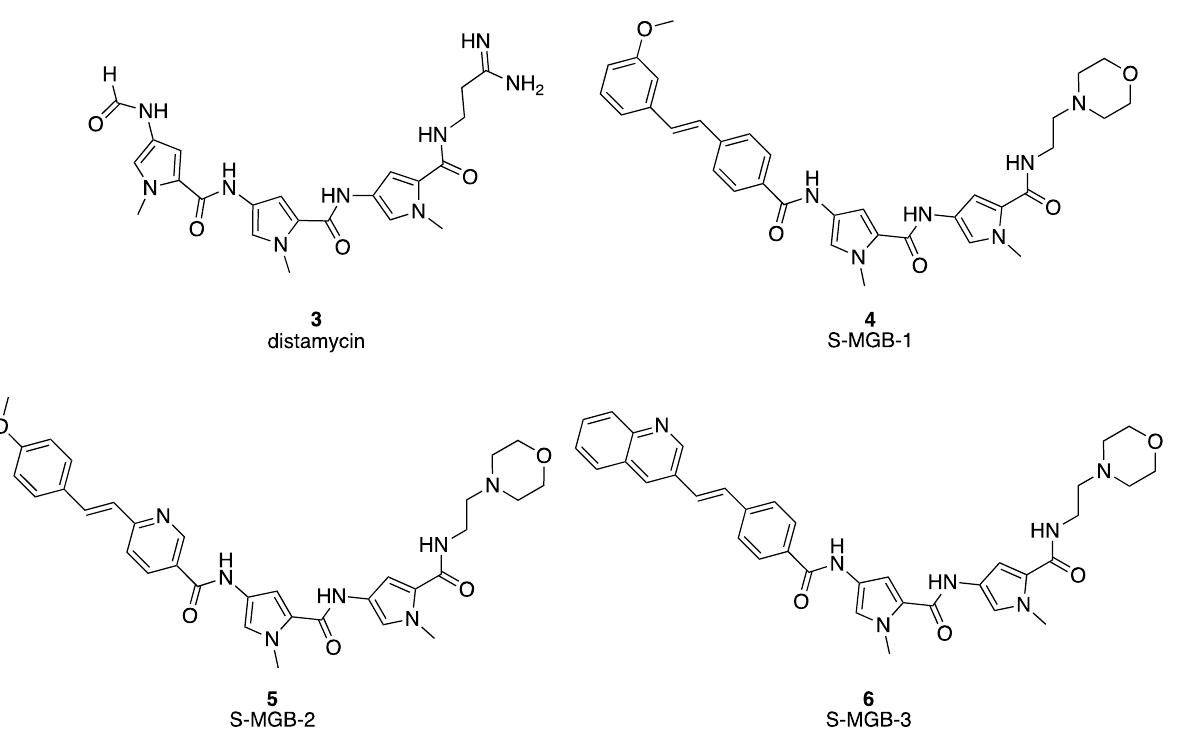
Figure 2. Structures of the natural product distamycin ( 3 ) and several Strathclyde minor groove binders bearing an isosteric alkene ( 4 – 6 ) .